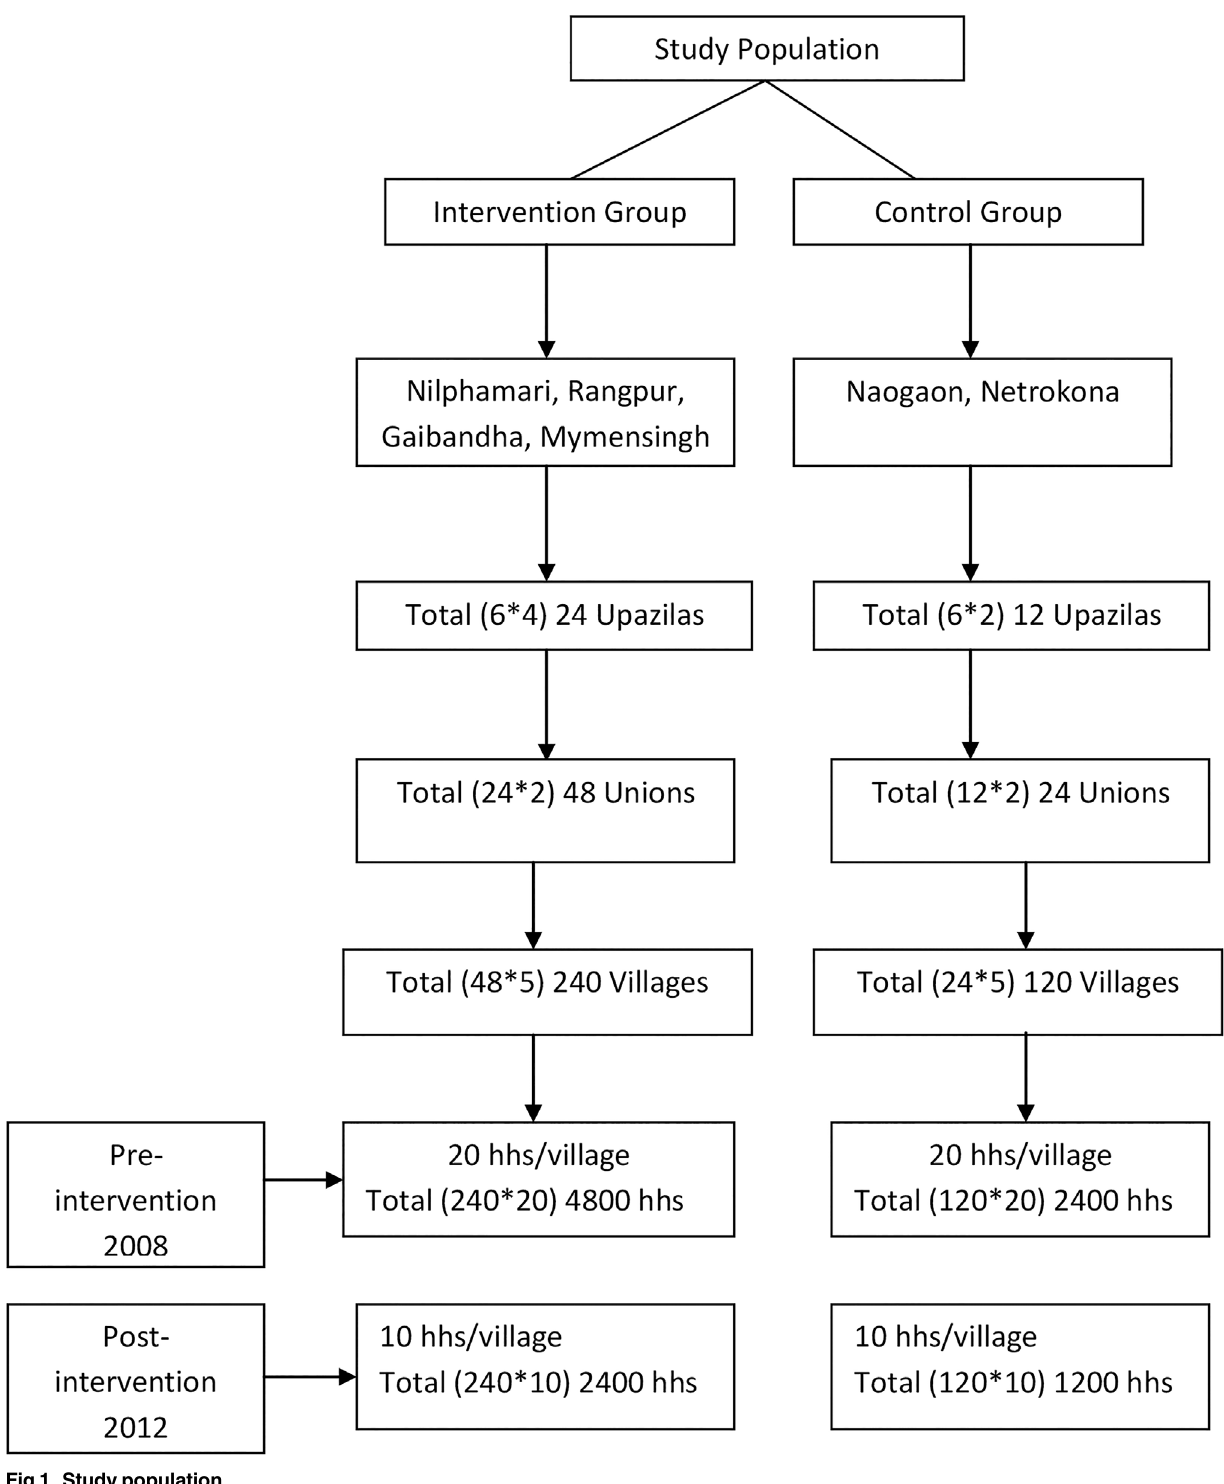
Fig 1. Study population.